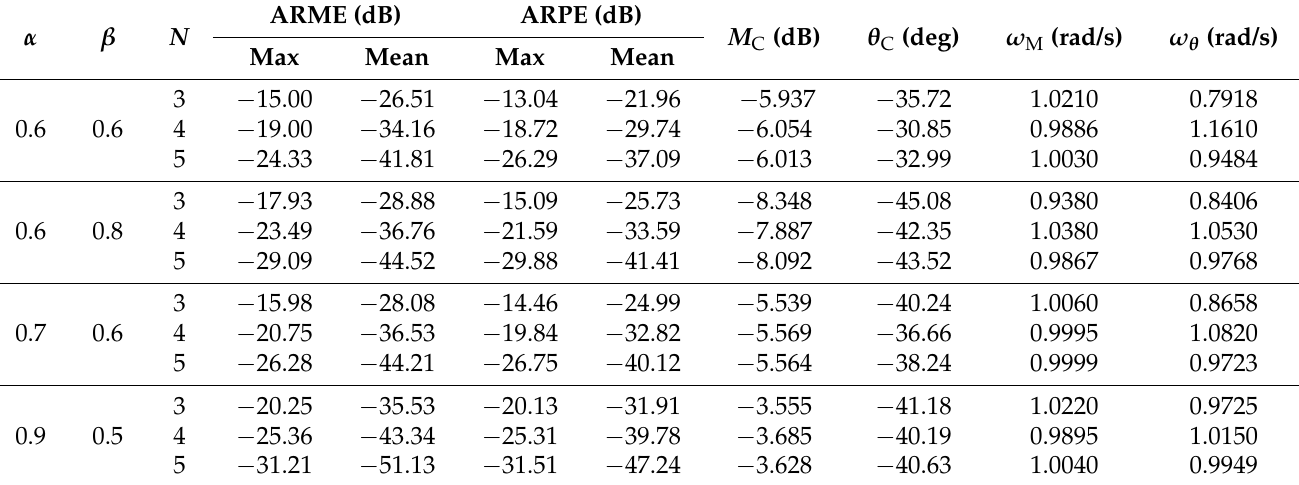
Table 3. Performance indices of the designed FLPFs for different values of N